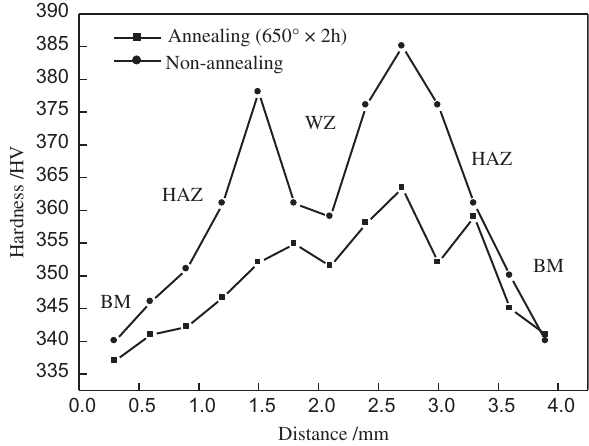
Figure 4: Curve of microhardness distribution of EBW joints for TA15 titanium